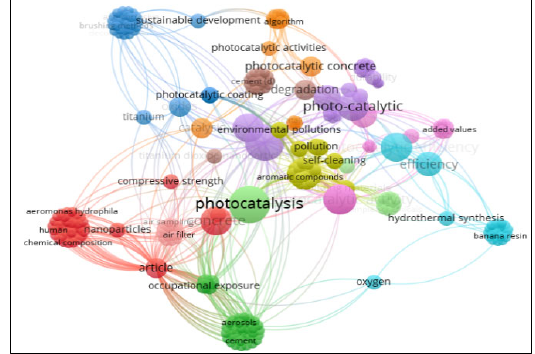
Fig. 3b. Map of the analysis of the words “Concrete”, “Photocatalytic”, “Environmental” and “Work” with the highest interaction